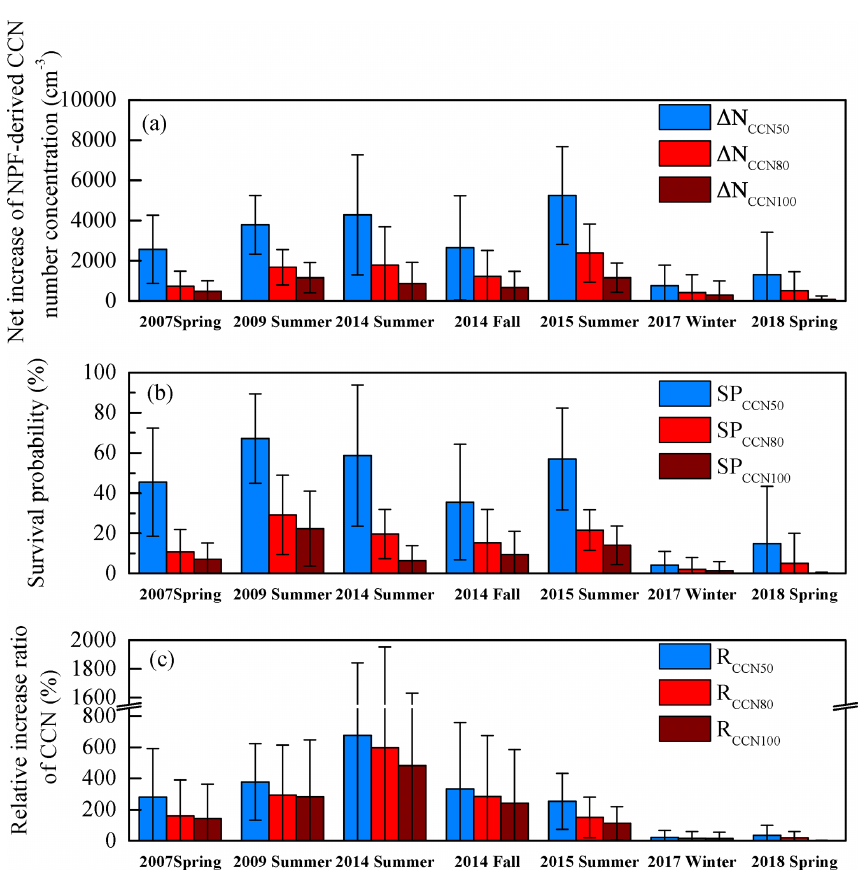
Figure 4. Campaign average of the net increase in the NPF-derived CCN number concentration ( (cid:49)N CCN , a ), the survival probability of new particles growing to CCN sizes (SP CCN , b ), and the relative increase ratio of the CCN population ( R CCN , c ) during the seven observation campaigns. The error bars are the standard